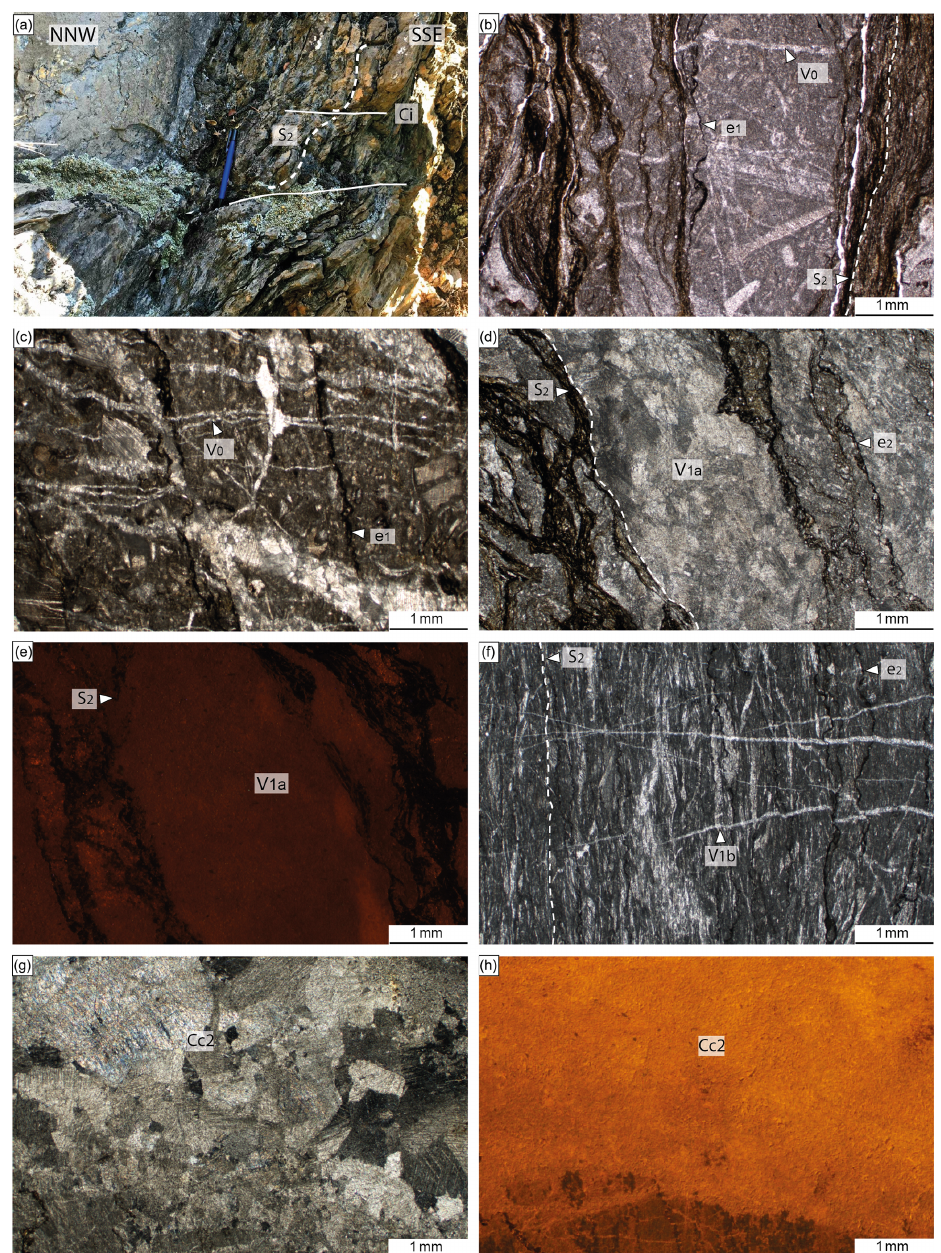
Figure 6. Mesostructures and microstructures found within the thrust zone affecting the hanging wall. (a) Outcrop image of the thrust zone foliation (S 2 ) and related C planes indicating reverse kinematics (Ci). Microphotographs of (b) thrust zone foliation (S 2 ), (c) stylolites e1 and veins V0 affecting the Devonian encrinites, and (d) cross-polarized light and (e) cathodoluminescence microphotographs of veins V1a concentrated between foliation surfaces. (f) Thrust zone foliation (S 2 ) near the fault plane and ambiguous and perpendicular relationships between V1b and e2. (g) Cross-polarized light and (h) cathodoluminescence microphotographs of calcite cement Cc2 located on the main thrust plane